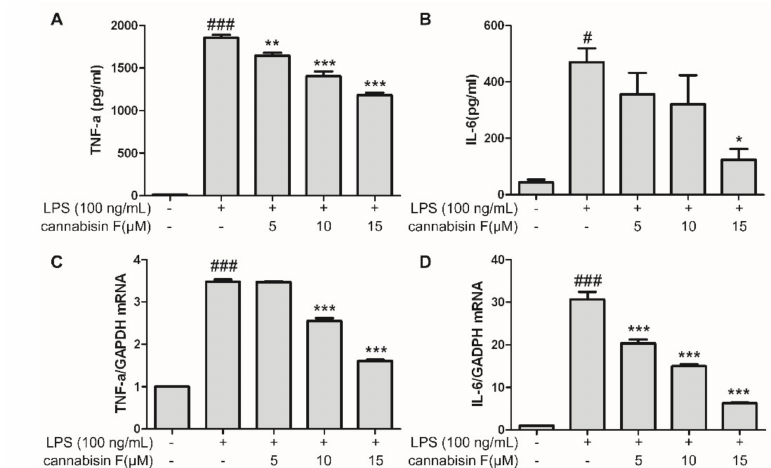
Figure 3. Cannabisin F inhibited IL-6 and TNF- α production ( A , B ) and their mRNA expression ( C , D ) in LPS-stimulated BV2 microglia cells. BV2 microglia cells were pretreated with cannabisin F (5, 10 and 15 µ M) for 1 h and then stimulated with LPS at 100 ng/mL for 24 h. The supernatants were harvested and the secretion of TNF- α ( A ) and IL-6 ( B ) were measured by ELISA. For qRT-PCR analysis, the mRNA levels of TNF- α ( C ) and IL-6 ( D )were determined after incubation with LPS at 100 ng/mL for 6 h. The data are presented as mean ± SD from at least three independent experiments. * p < 0.05, ** p < 0.01, *** p < 0.001 as compared to the cells treated with LPS; # p < 0.05, ### p < 0.001 as compared to the control.